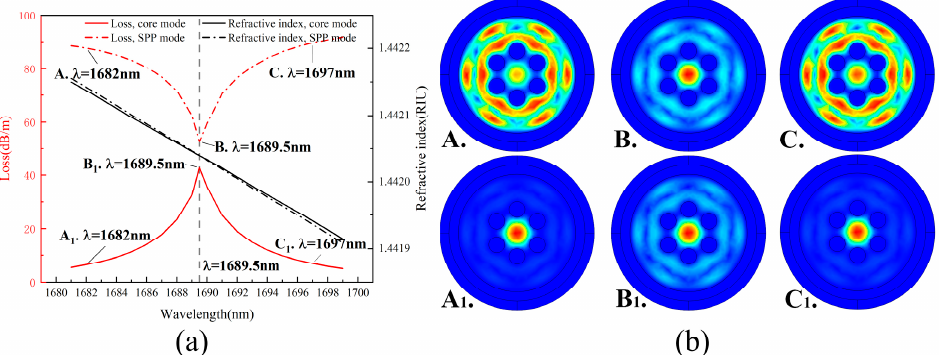
Figure 6. ( a ) Coupling relation diagram between the SPP mode and the fundamental mode; ( b )